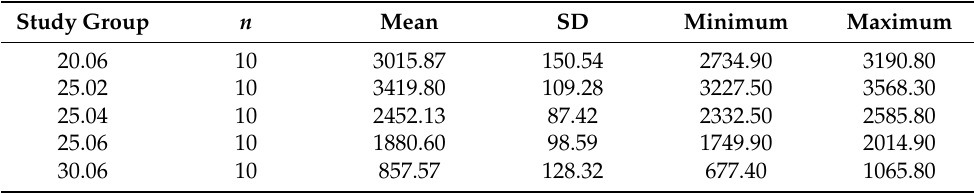
Figure 6. Weibull probability plots of the time to failure for the ( A ) apical diameter and ( B ) taper study groups. The scale distribution parameter ( η ) of the Weibull statistics showed statistically significant differences between the time to failure of the 25.02 and 25.04 taper study groups ( p < 0.001), 25.02 and 25.06 taper study groups ( p < 0.001), and 25.04 and 25.06 taper study groups ( p < 0.001). However, the shape distribution parameter ( β ) of the Weibull statistics did not show statistically significant differences between the time to failure of the 25.02 and 25.04 taper study groups ( p = 0.148), 25.02 and 25.06 taper study groups ( p = 0.287), and 25.04 and 25.06 taper study groups ( p = 0.702) (Table 2, Figure 6B). The mean and SD values for number of cycles to failure regarding the apical diameter and taper are displayed in Table 3 and Figure 7A,B. Table 3. Descriptive statistics of the number of cycles to failure in relation to the apical diameter and taper study